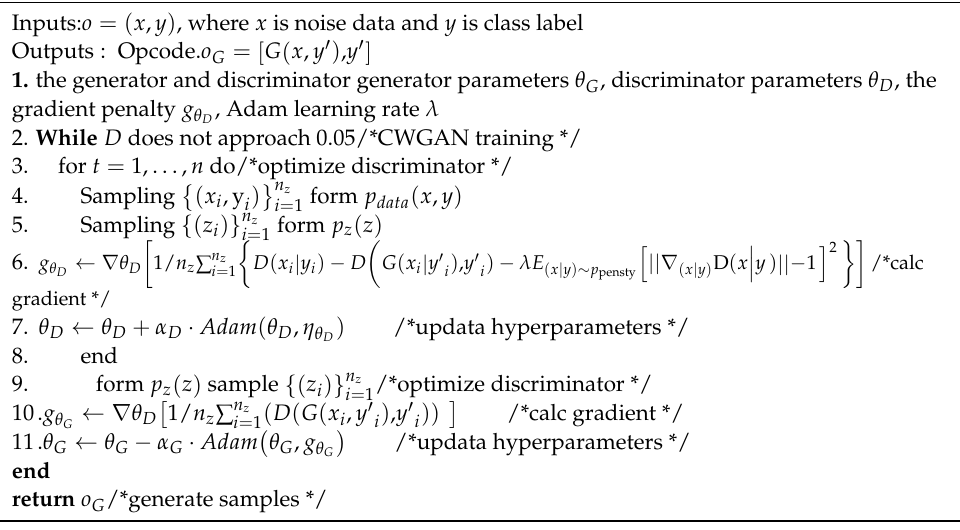
Algorithm 1: Minority class sample generation based on CWGANs